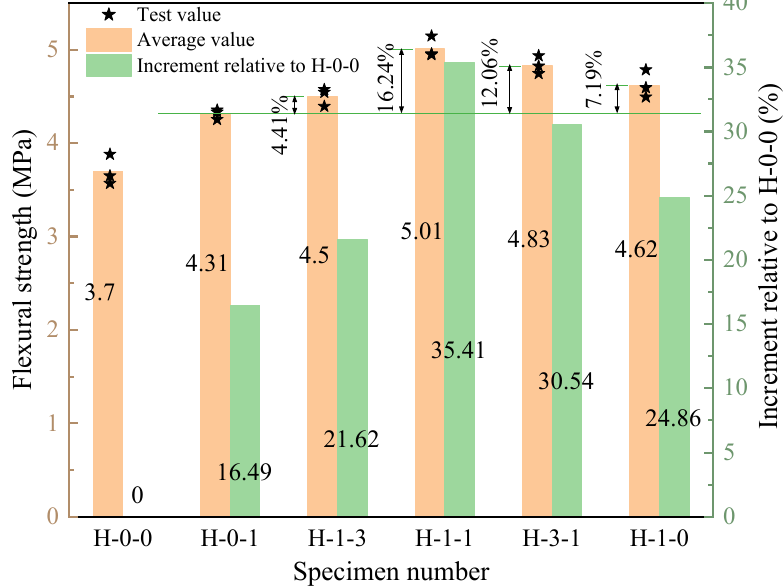
Figure 10. Flexural strength of LHPCC with different fiber hybrid proportions.